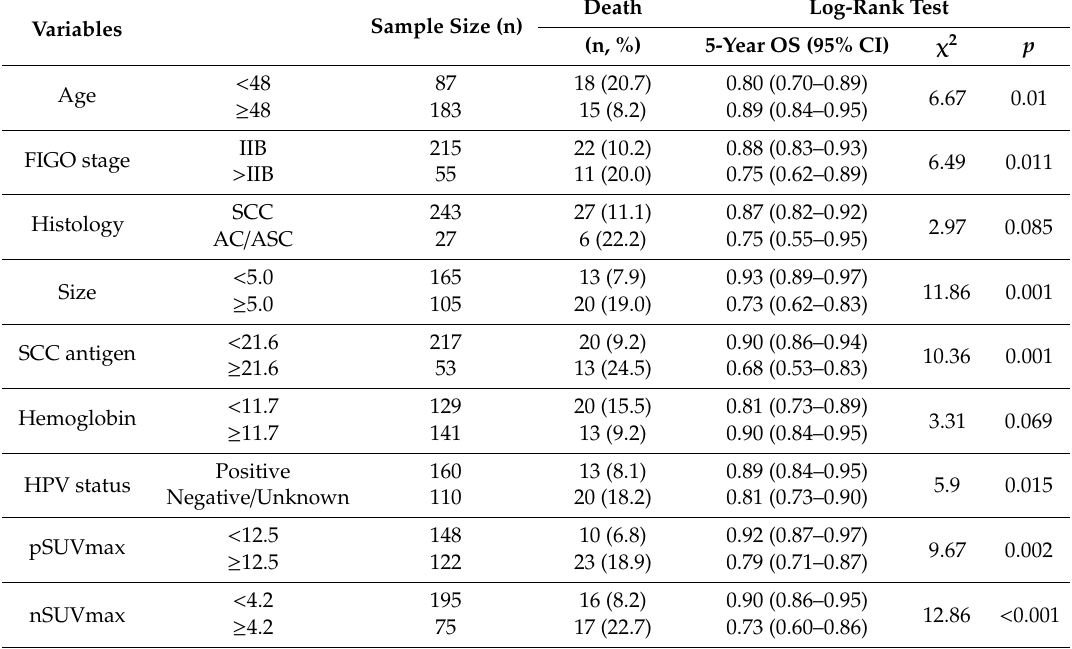
Table 2. Clinicopathologic and [ 18 F]fluorodeoxyglucose PET metabolic parameters of the model derivation cohort for 5-year overall survival.